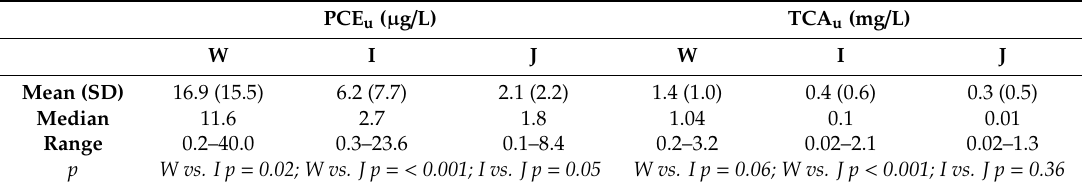
Table 3. Results of the evaluation of occupational perchloroethylene (PCE) exposure in the sample of dry-cleaning operators classified according to their working tasks as “washers”, “ironers”, and “jolly”. Data obtained from the end of the work shift urines on PCE concentration (PCE u ) and trichloroacetic acid concentration (TCA u ) are